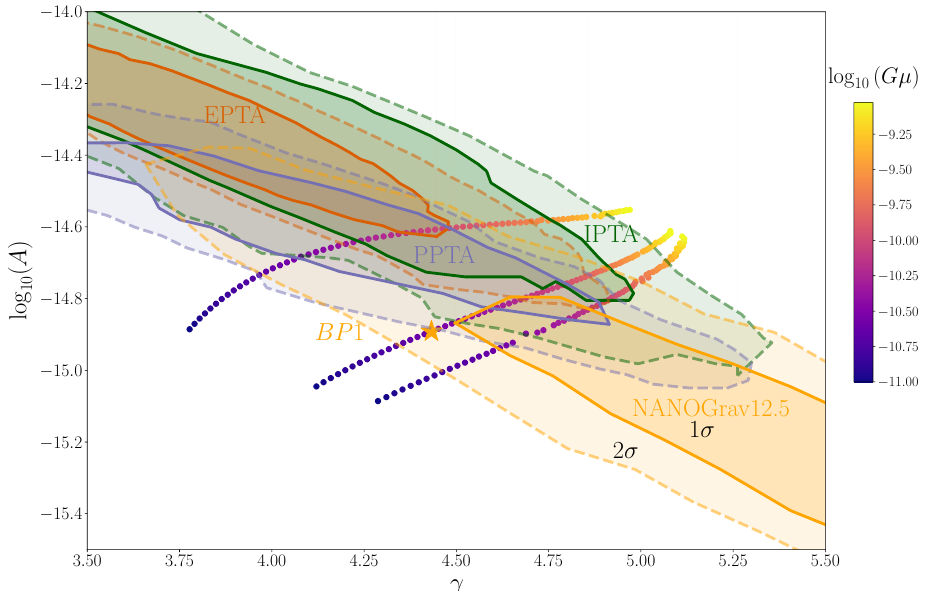
Figure 8 . Comparison between SGWB signals produced by cosmic strings with Gµ from 10 − 11 to 10 − 9 the possible 1 σ and 2 σ regions hinted by EPTA, PPTA, IPTA and NANOGrav. The SGWB signal has been fitted for three frequencies: 2.4 nHz, 5.4 nHz and 12 nHz. The simulation shows that the signal is compatible with all experiments at 2 σ . The orange star indicates the prediction of ( γ, A ) in BP1.